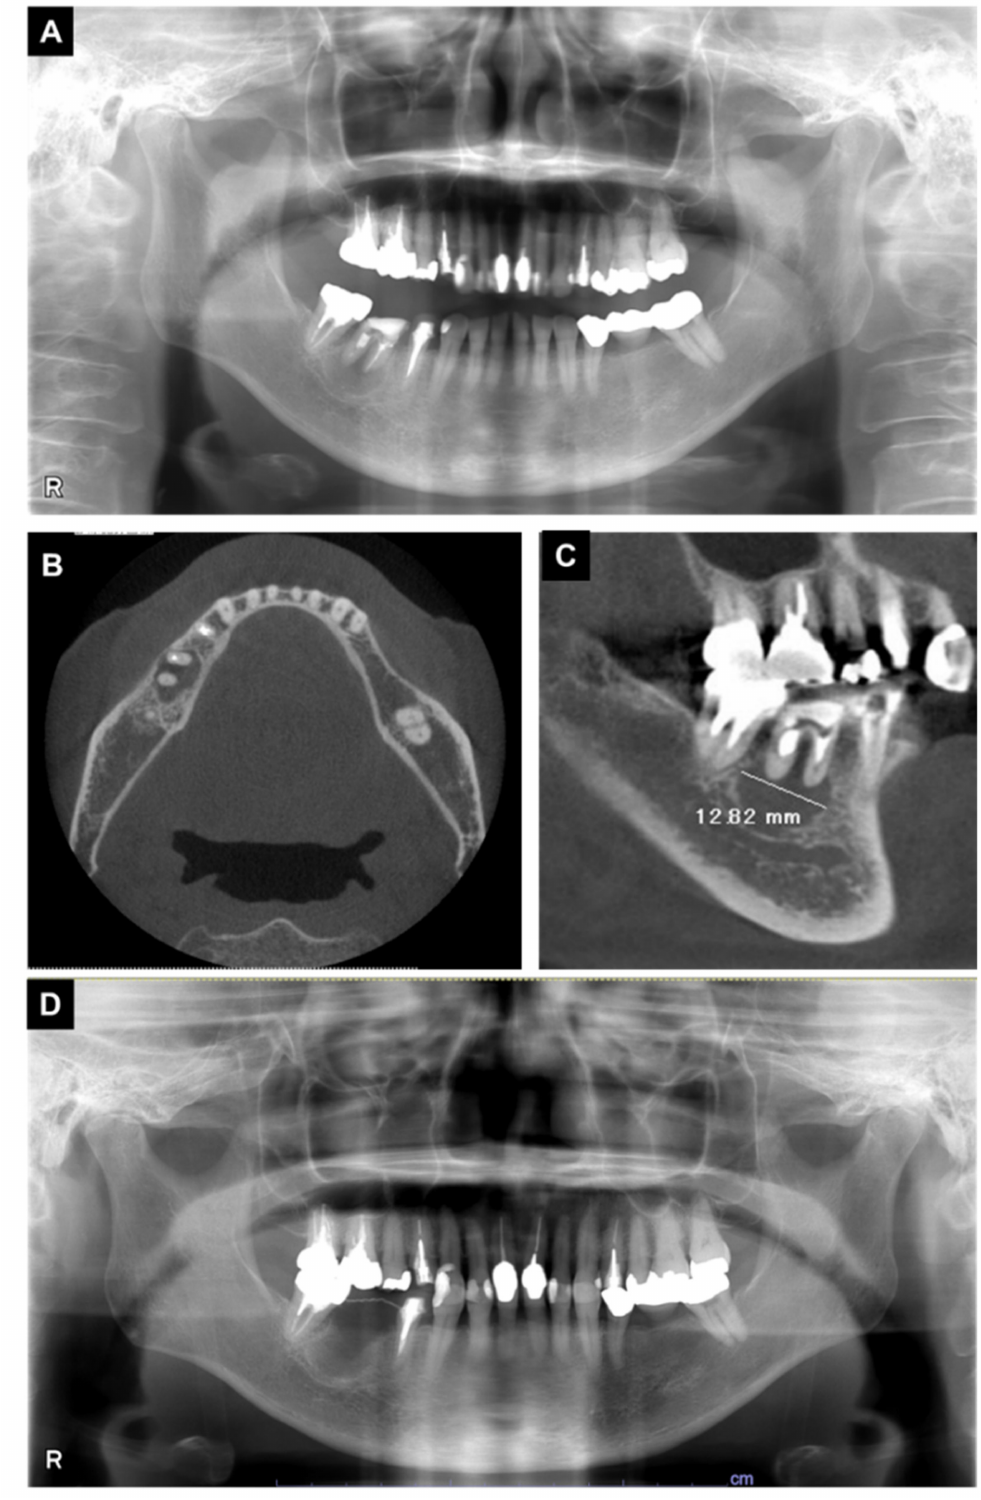
Figure 4. X-ray examination findings during the initial visit. ( A ) Panoramic radiography; ( B , C ) computed tomography images. Radiolucent findings were observed at the root apex of the first molar. ( D ) Panoramic radiography images after